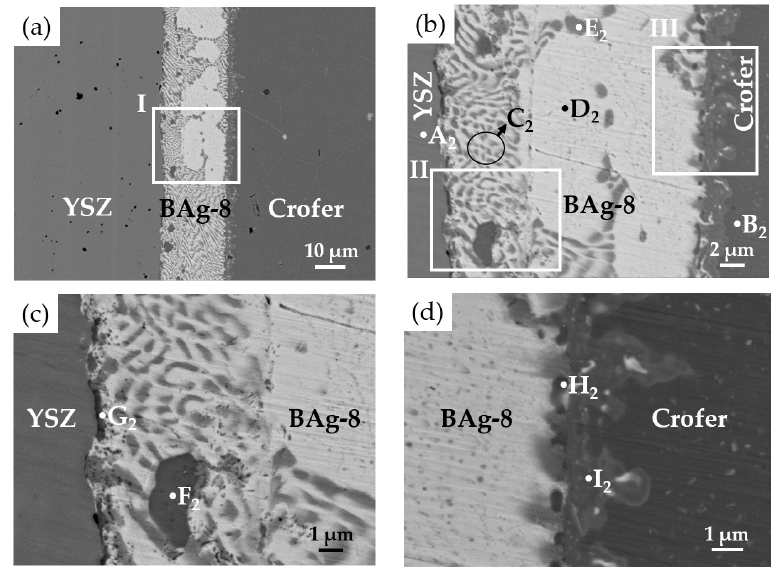
Figure 6. EPMA BEIs of the BJ-2 vacuum brazed at 850 °C for 600 s: ( a ) Cross section of the joint, ( b ) higher magnification of area I in ( a ), ( c ) YSZ side of area II in ( b ), and ( d ) Crofer side of area III in ( b ). Table 3. EPMA WDS quantitative chemical analyses of BJ-2 in Figure 6(b–d). Element 1 /at%